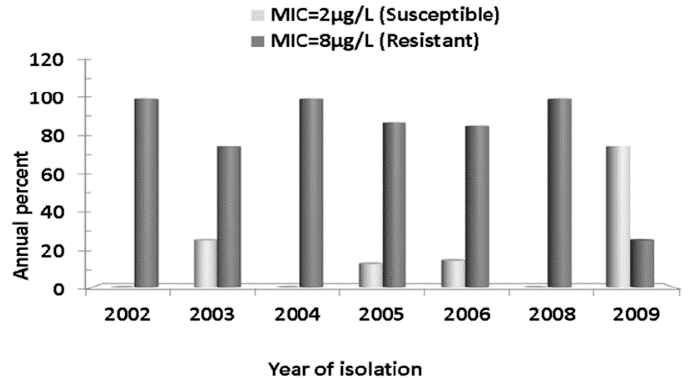
Figure 2. Annual percent distribution of tetracycline resistant Streptococcus pneumoniae serotype 1 recovered from meningitis cases from 2002 to 2009 in Niger. The figure shows that resistant isolates prevailed over susceptible ones every year except in 2009. No isolate from 2007 was tested.